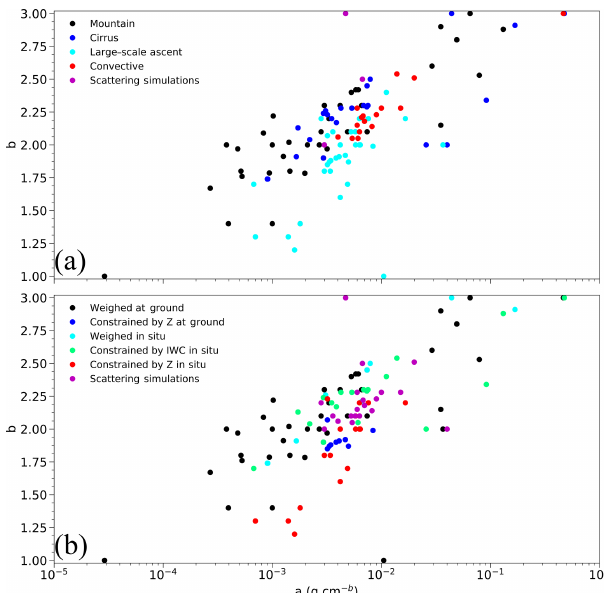
Figure 1. Distribution of a and b coefficients used for characteriz- ing m = aD b relationship from past studies. Points colored by the (a) environment in which measurements were taken and (b) tech- nique used to derive the